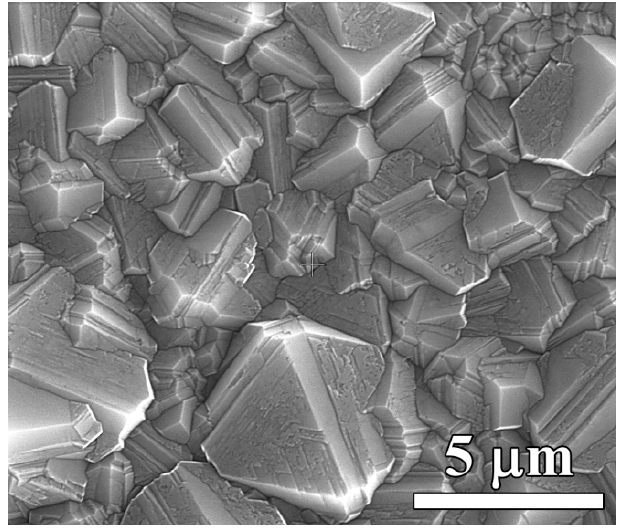
Figure 2. SEM image of the 5.9 μ m thick polycrystalline diamond film grown on silicon.